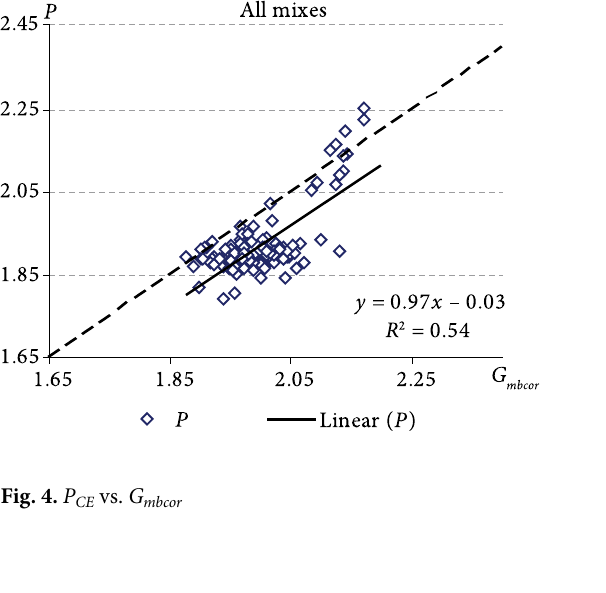
Fig. 5. P CE vs. W